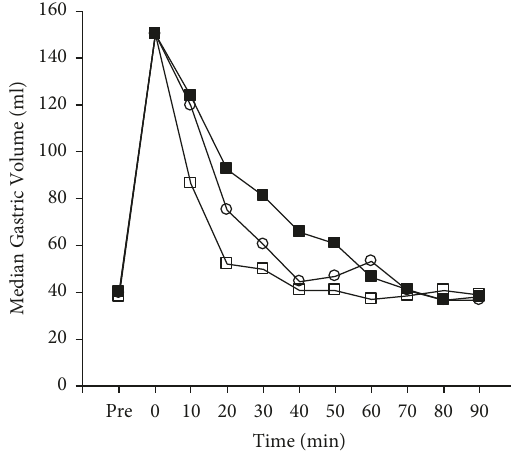
Figure 3: Changes in medians of calculated gastric volumes over time after the ingestion of one of 3 different beverages. Whisky group (ˆx), 150ml of diluted whisky (30ml of whisky+120ml of water, 67kcal); sugar group ( ■ ), 150ml of 12.5% glucose solution (67kcal); water group ( □ ), 150ml of water